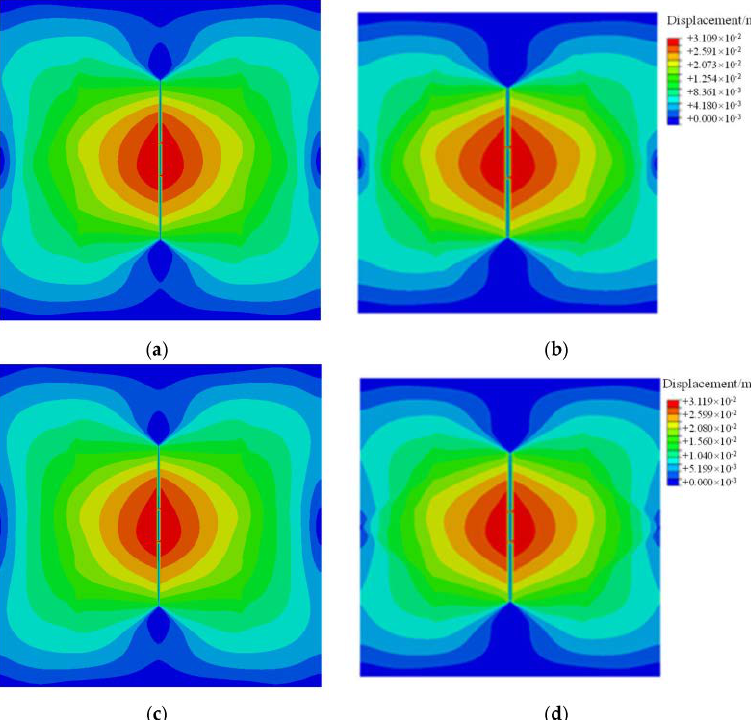
Figure 8. Cloud picture of displacement under different internal frictional angles of shale oil reservoir: ( a ) internal frictional angle of 8 ◦ and time t = 55 s; ( b ) internal frictional angle of 8 ◦ and time t = 100 s; ( c ) internal frictional angle of 17 ◦ and time t = 55 s; ( d ) internal frictional angle of 17 ◦ and time t = 100 s.